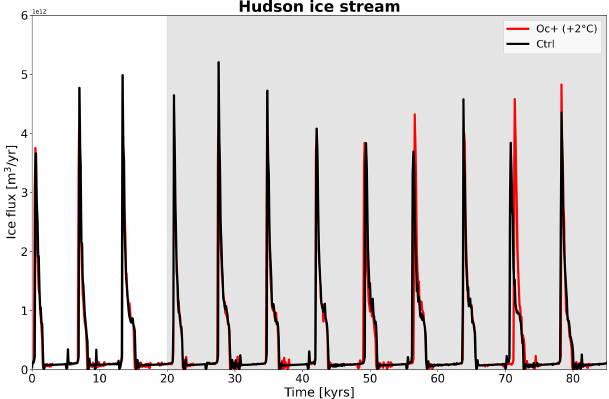
Figure B2. Time series of ice flux through the flux gate (Fig. 1) for ocean perturbation for Hudson ice